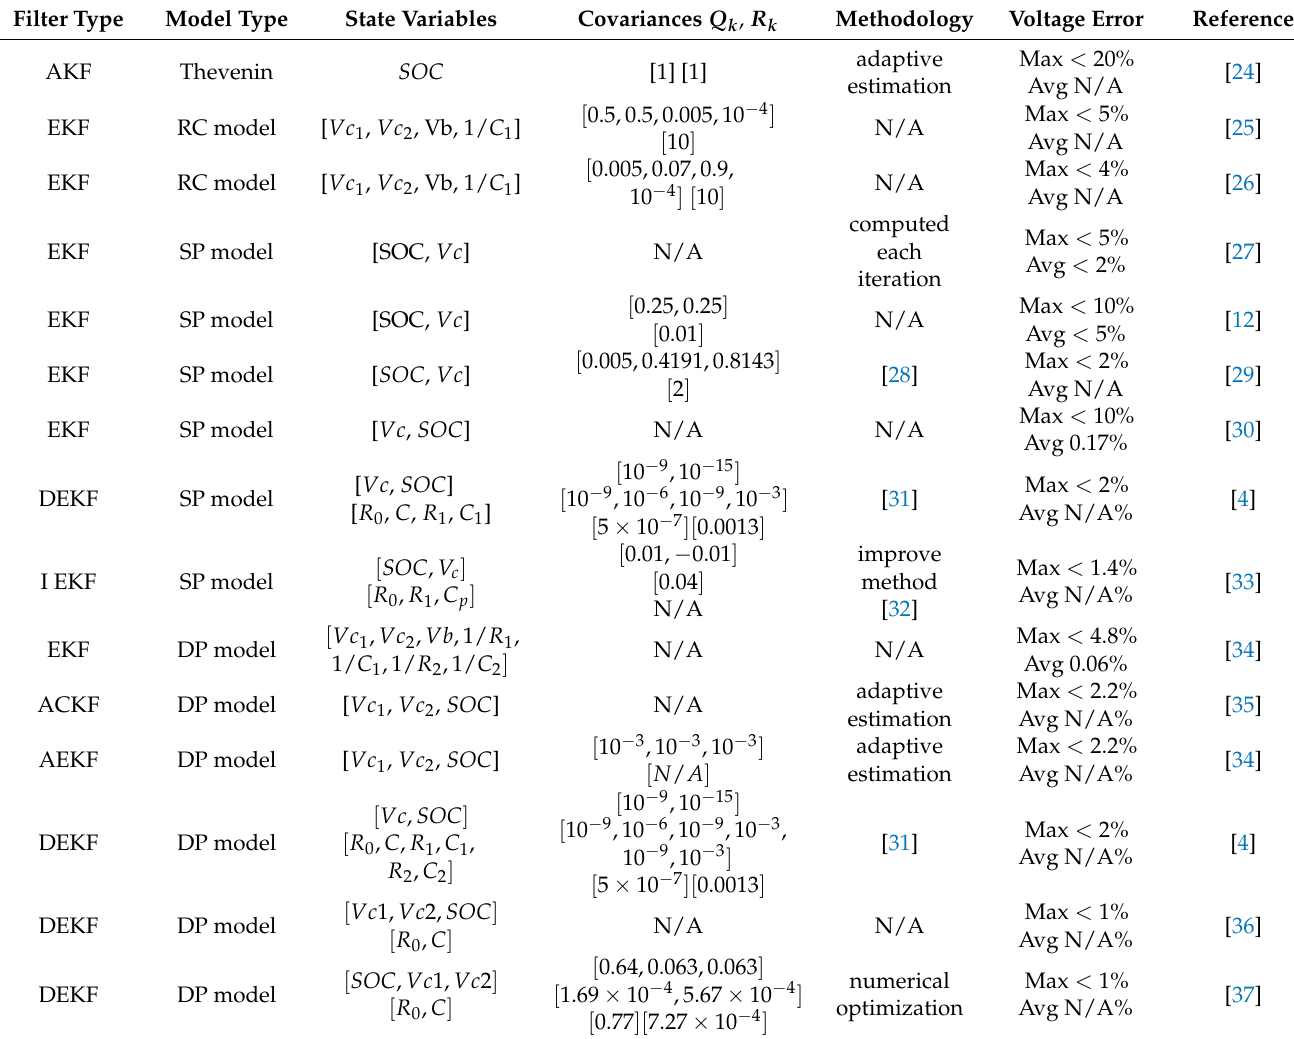
Table 3. Summary of EKF literature applied to battery state